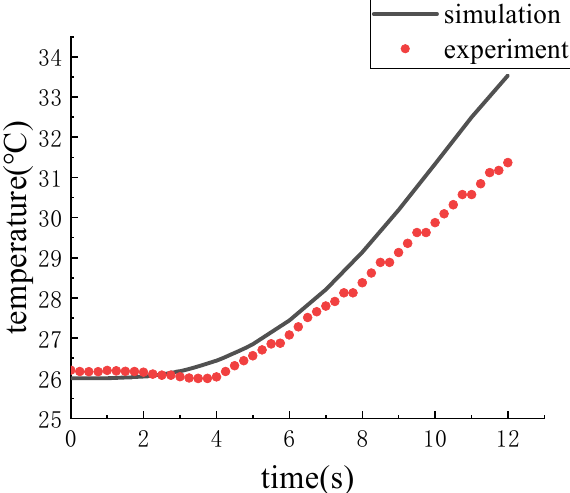
Figure 20. Test and Simulation temperature curve.